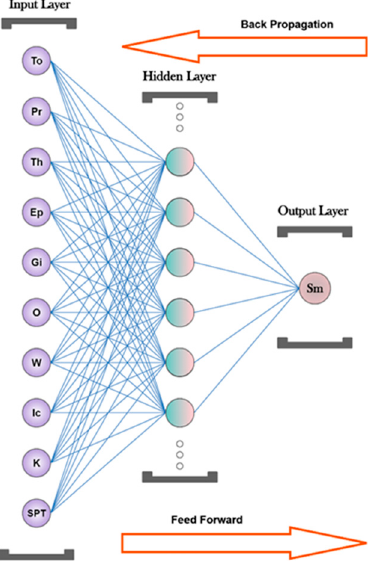
Figure 6. Schematic diagram of utilized ANN models.